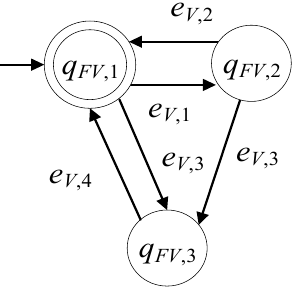
Figure 2. The state diagram of the automaton of the valve including fault.